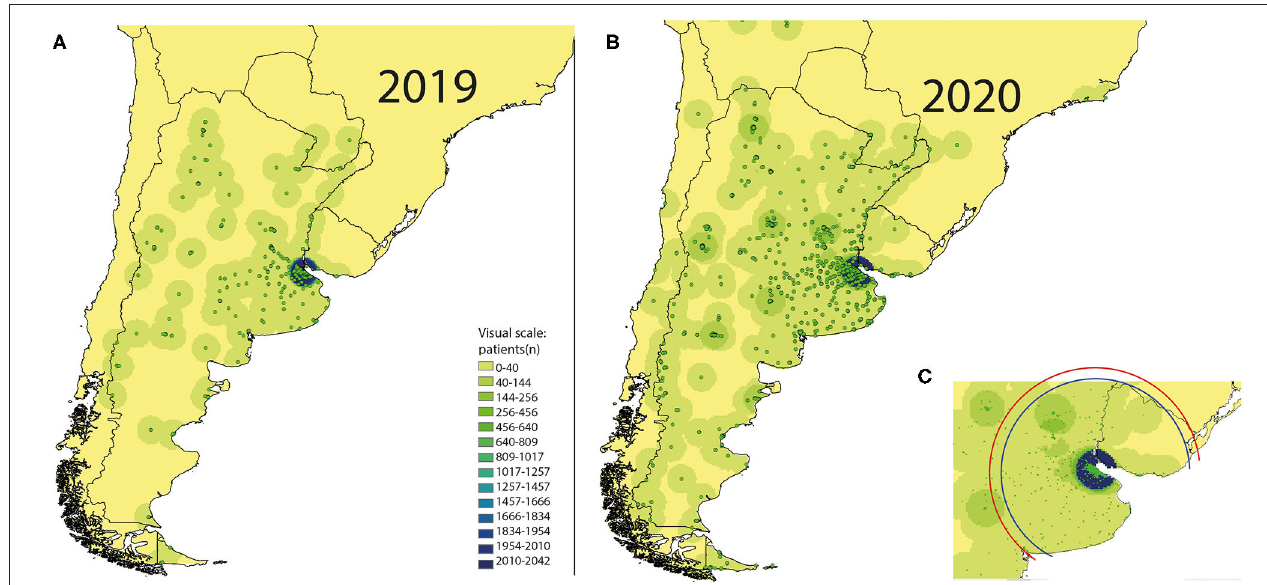
FIGURE 3 | Changes in the geographical area of influence of our center due to the introduction of telemedicine. The points and point densities represent the number of patients according to the geographical location of their addresses. Compared to 2019 (A) , in 2020 (B) , more patients from distant areas of Argentina and bordering countries had access to our center. During the study time frame, all the national and international borders remain closed. Thus, the observed changes can be attributed to the introduction of telemedicine. (C) shows the standard distance measured from the patient’s addresses to our center in 2019 (blue circle = 109km) and 2020 (red circle =